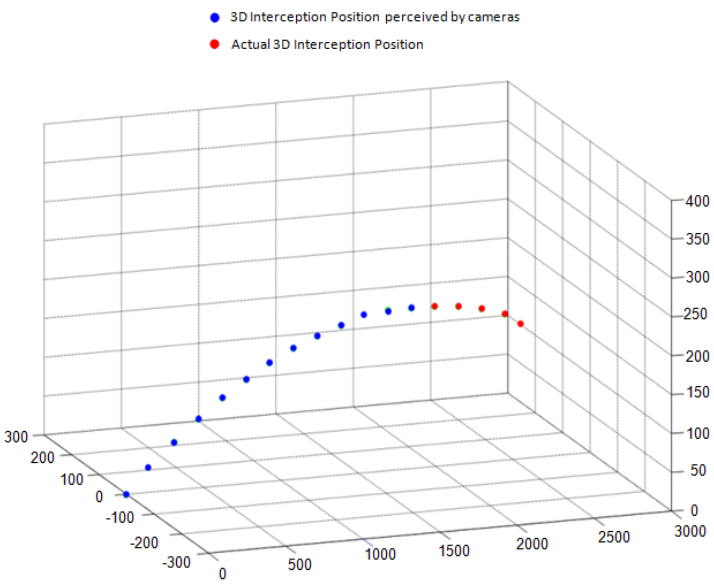
Figure 7. Sample dataset throw.